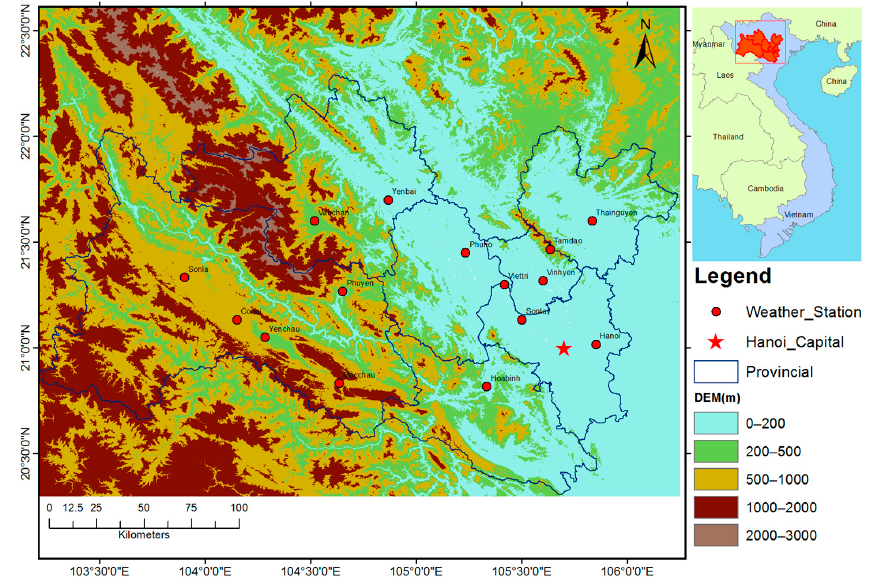
Figure 1. Location of the 15 meteorological stations in northern Vietnam and the range of elevations in the study area.